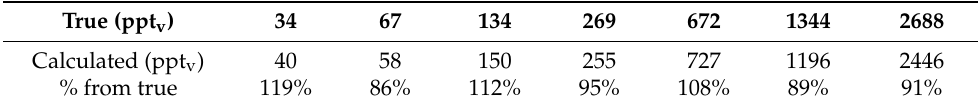
Table 6. Calculated recovery of standards, done in 50% humid air.